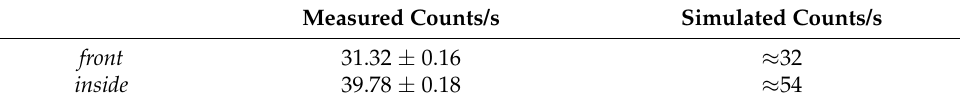
Table 1. Comparison of the measured neutron counting rates to the expectation from simulations.